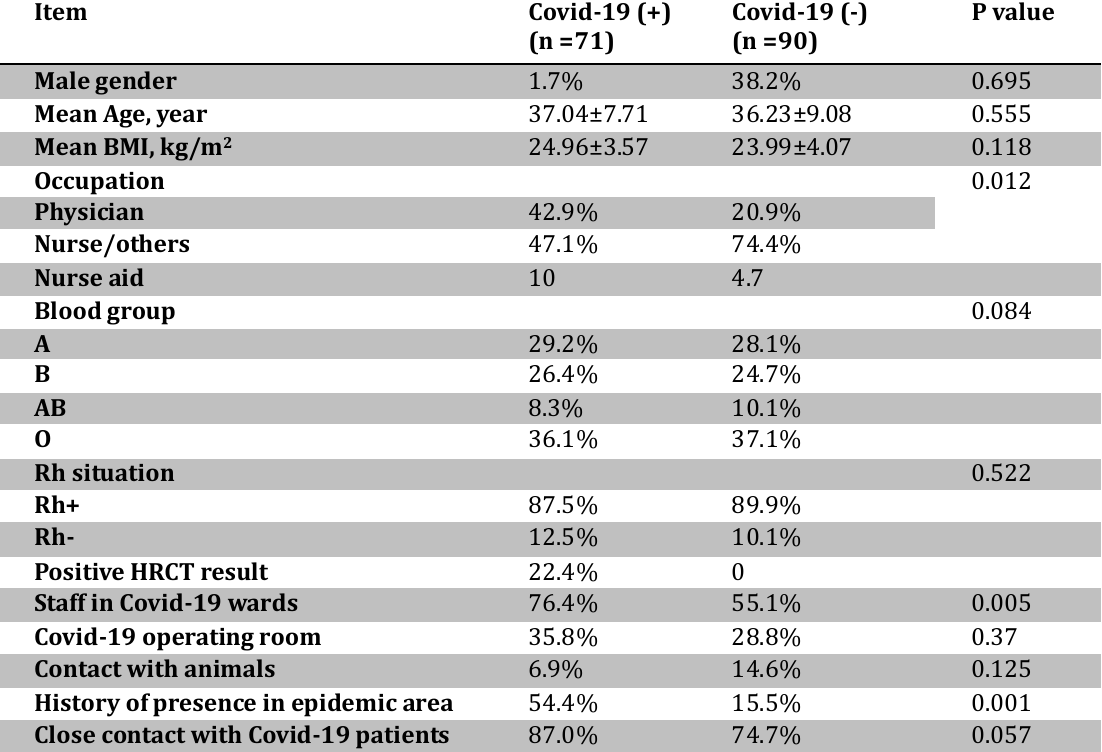
Table 1 : Baseline characteristics among personnel with and without Covid-19